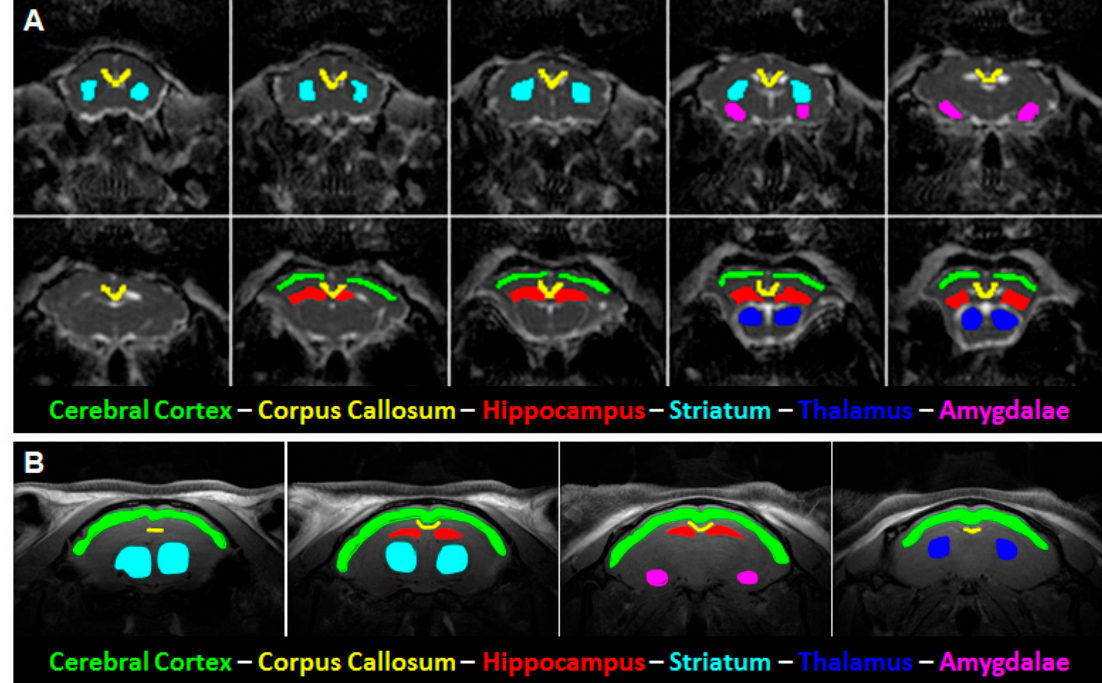
Figure 1. Representative mean diffusivity (MD) and T2-weighed images with delineated regions of interest (ROIs). ( A ) ROIs used for diffusion tensor imaging (DTI) and diffusion kurtosis (DKI) analyses were manually outlined on the MD image. ( B ) ROIs used for T2 relaxometry were manually outlined on a matching T2 image (left, showing cortical ROI). The slope of the ROI intensity over multiple echo times (TE) within the image was automatically plotted and fitted to arrive at the calculated T2 relaxation time.